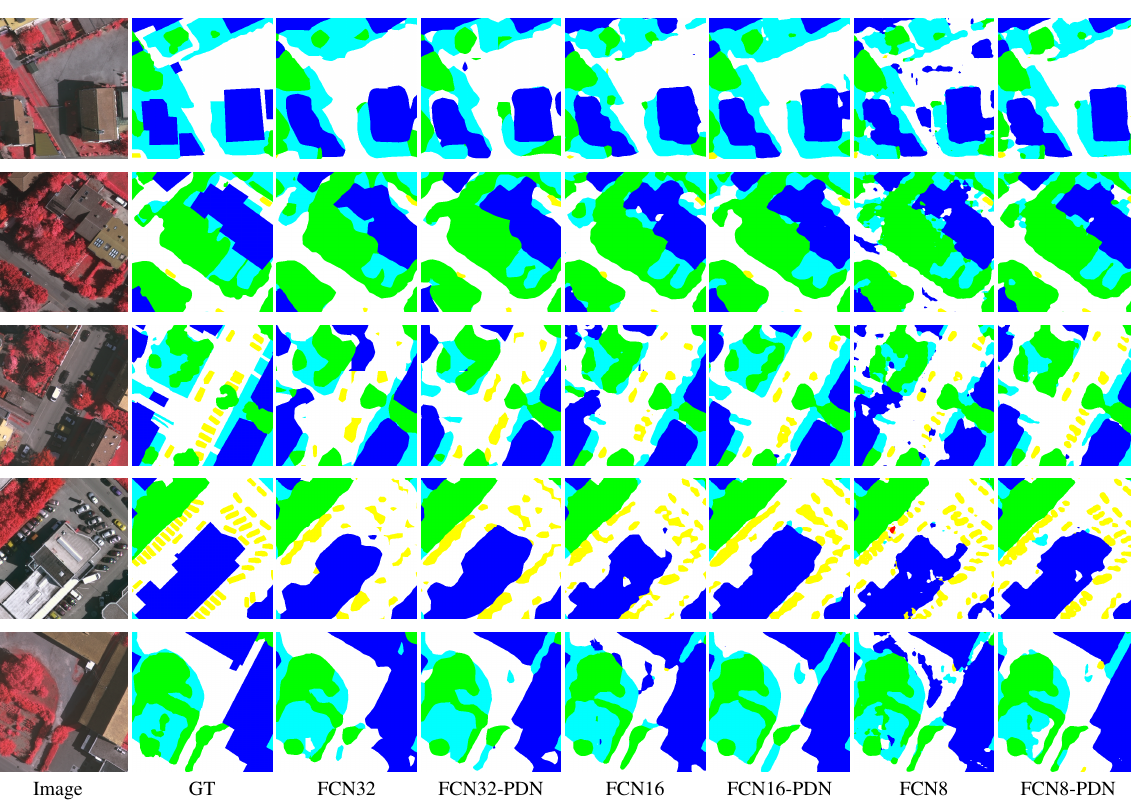
Table 2. Quantitative results on Vaihingen by using FCN framework with different upsampling strides.